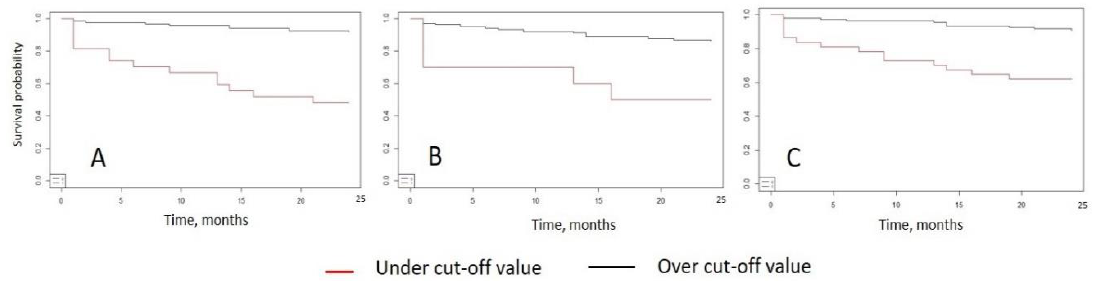
Figure 5. CV Kaplan-Mayer survival curves in two-year FU analyses under and over cut-off values for NT-pro-BNP ( A ), ST2 ( B ) and Ptx-3 ( C ).